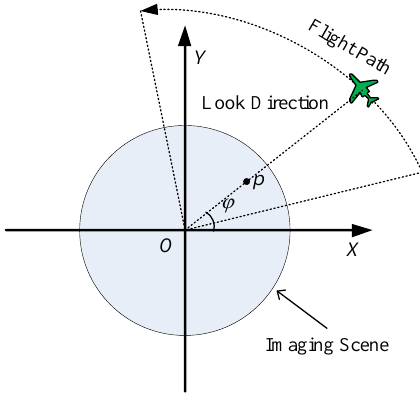
Figure 1. Geometric model of the wide-angle SAR synthetic aperture radar (SAR) imaging.